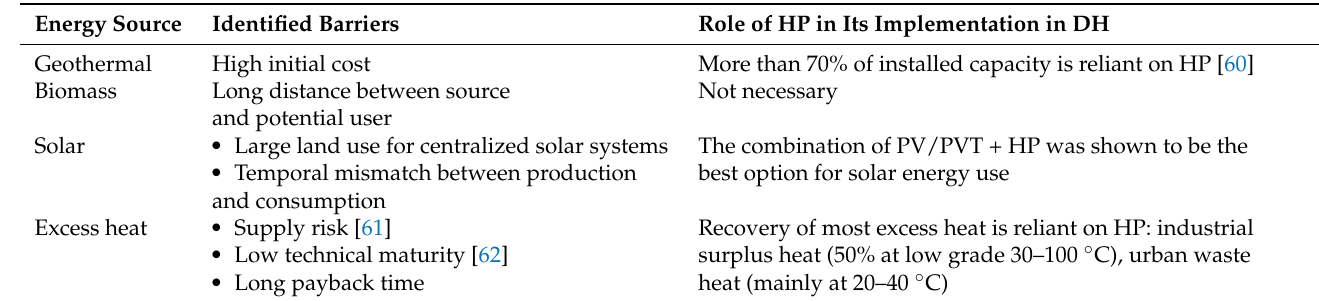
Table 3. Identified barriers for the utilisation of sustainable resources in DH systems. Energy